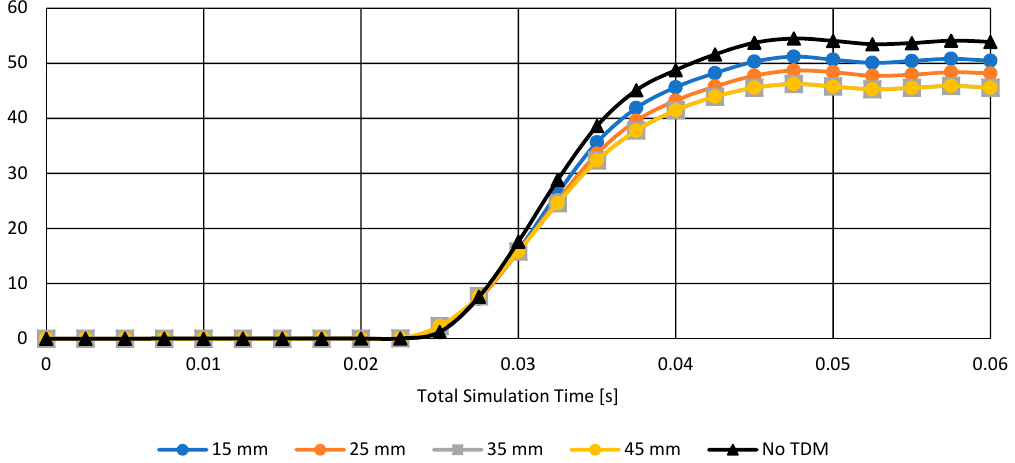
Figure 6. FEA results from energy absorptions of the street pole after being collided by a vehicle (frontal collision) using five different thicknesses of TDM shielding.